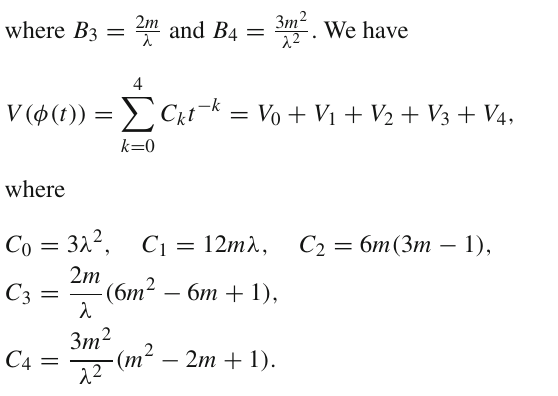
Toanalyzethedynamics, takingintoaccount thecondition | λ | (cid:7) 1, we will consider the normalized constant parameter ˜ λ = λ × 10 − 6